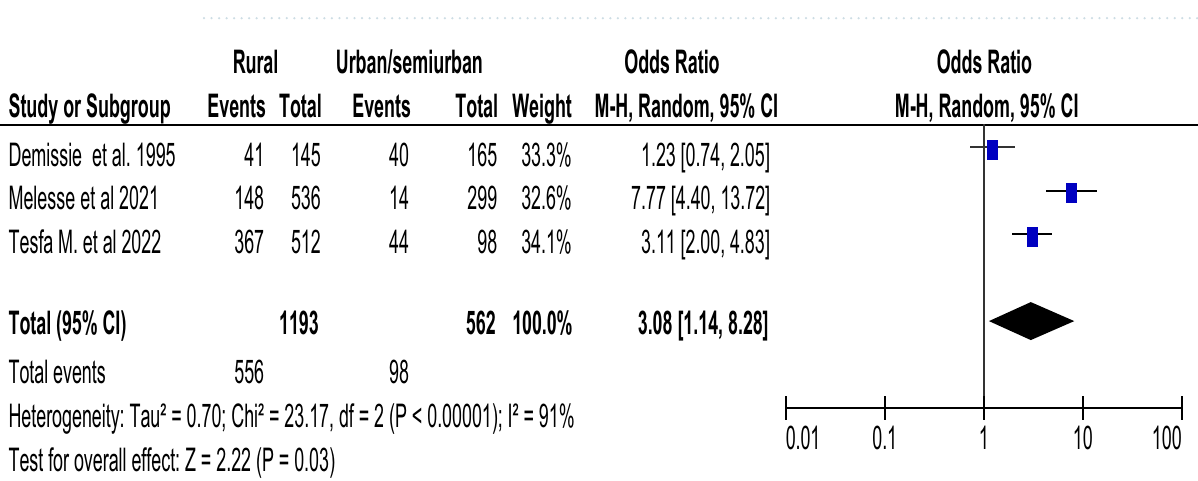
Figure 9. Forest plot using adjusted odds ratio for the association of ANC with food taboo practices among pregnant woman in Ethiopia, 2022.